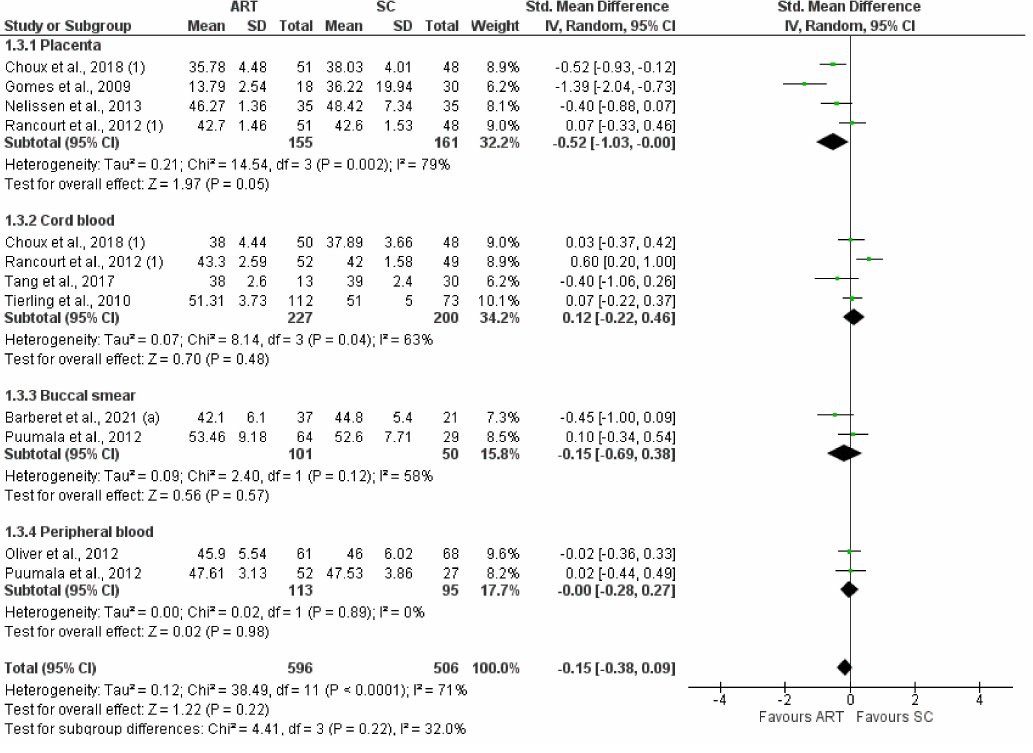
Figure 4. Methylation levels of KCNQ1OT1 [25,33,39,52,55,58,59,65,66]. ART, assisted reproductive technique; SC, spontaneous conception.